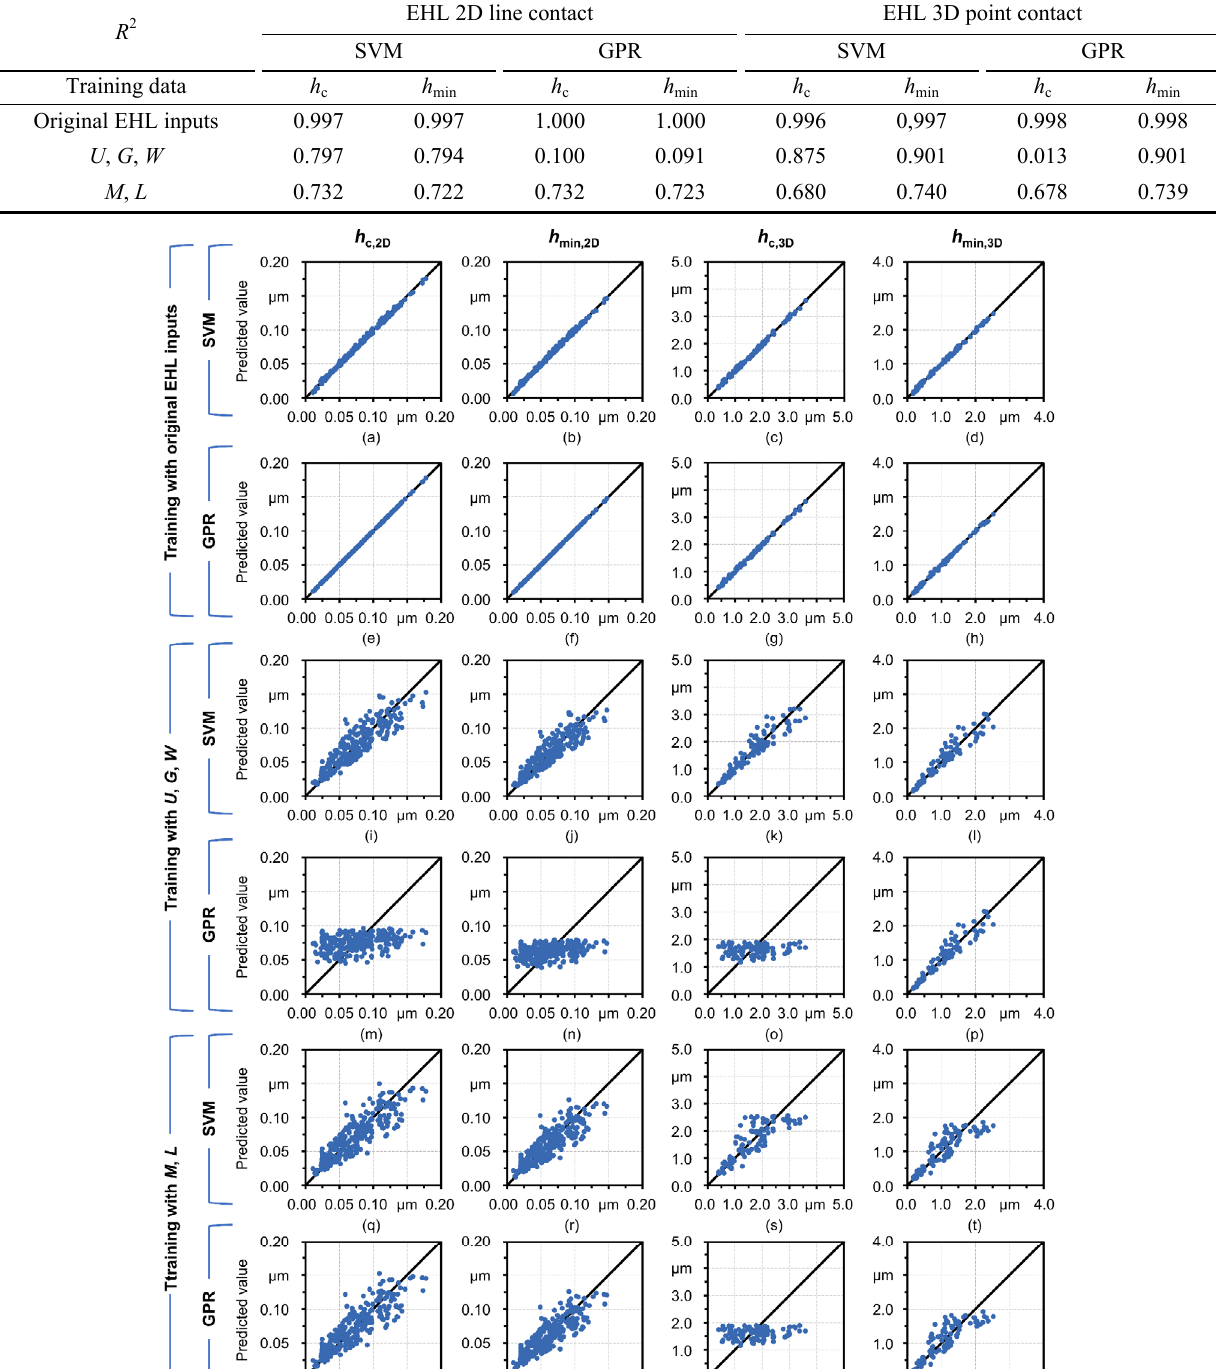
Table 5 Coefficients of determination of the SVM and GPR predictions for the central and minimum film thicknesses for the infinite 2D line and 3D circular point contacts against testing data after training with the original EHL inputs, the non-dimensional parameters U , G , W , or M , L .